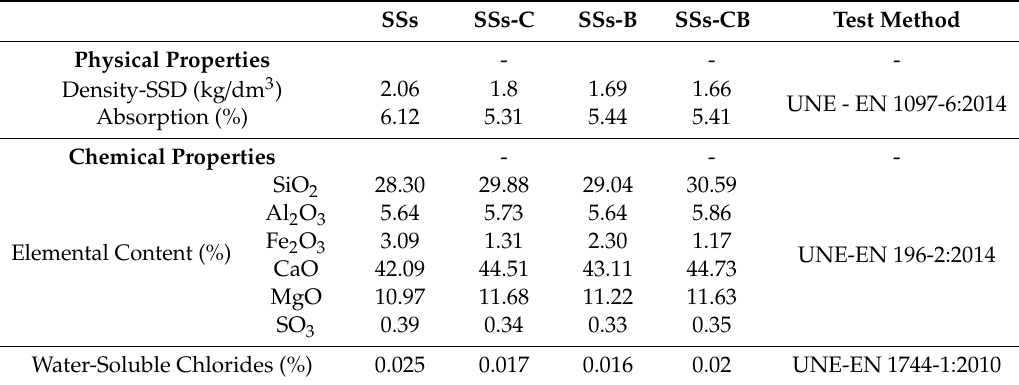
Table 1. Physical and chemical properties of SSs.